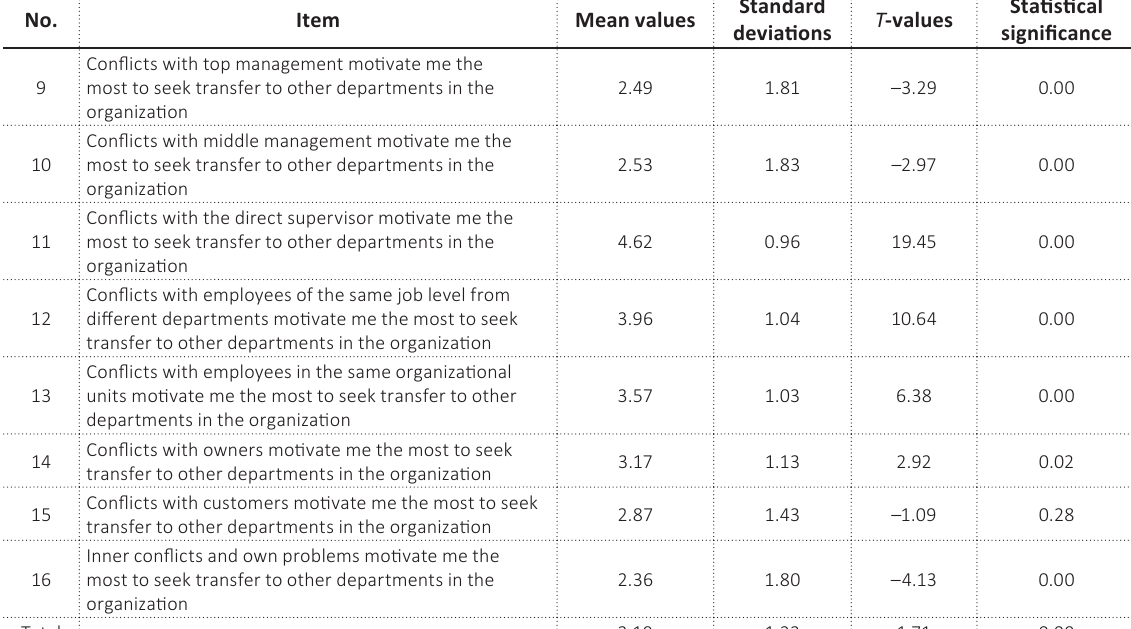
Table 5. Means, standard deviations, and T-values for internal turnover